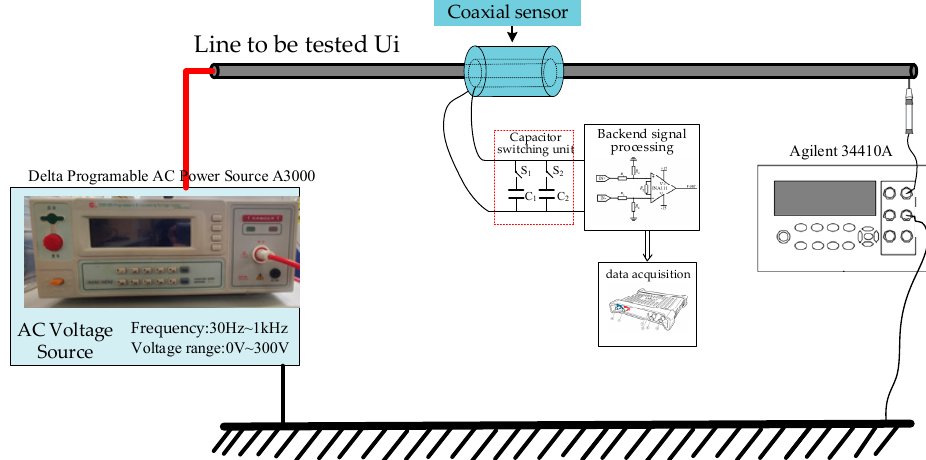
Figure 11. Schematic diagram of the sensor low-voltage performance test experiment.